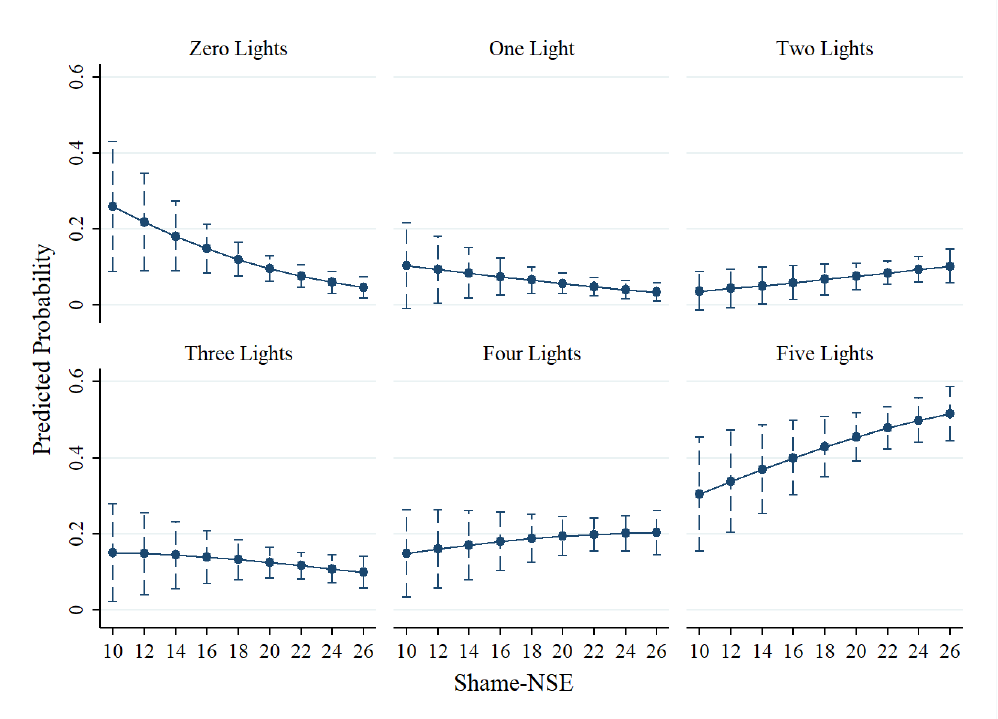
Figure 5. Predicted probability of number of lights by shame-NSE score. Note: This figure uses the multinomial logit regression results from Table A4. Dashed lines indicate 95% Confidence Intervals.